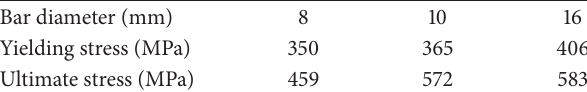
Table 3: Esfahani et al. test results of reinforcing